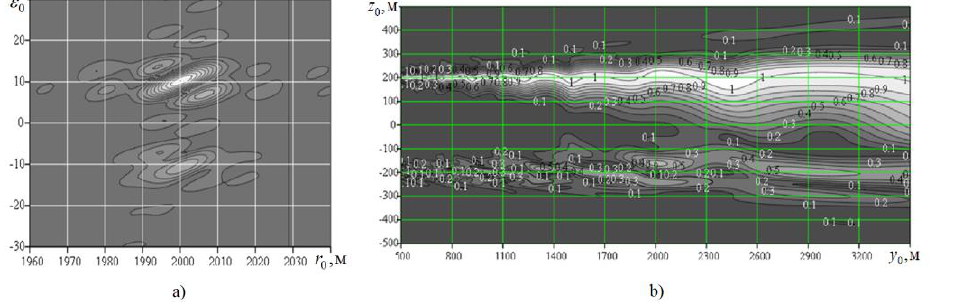
0 x x   and z = 200 0